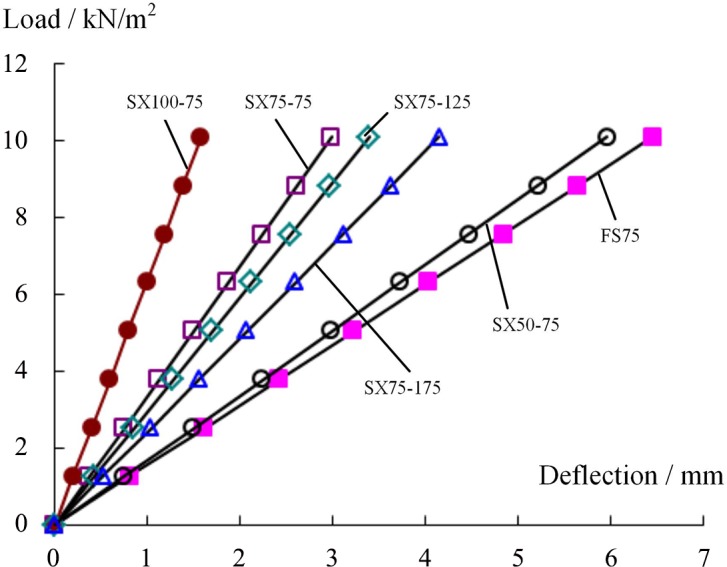
Load-central point vertical displacement curve.